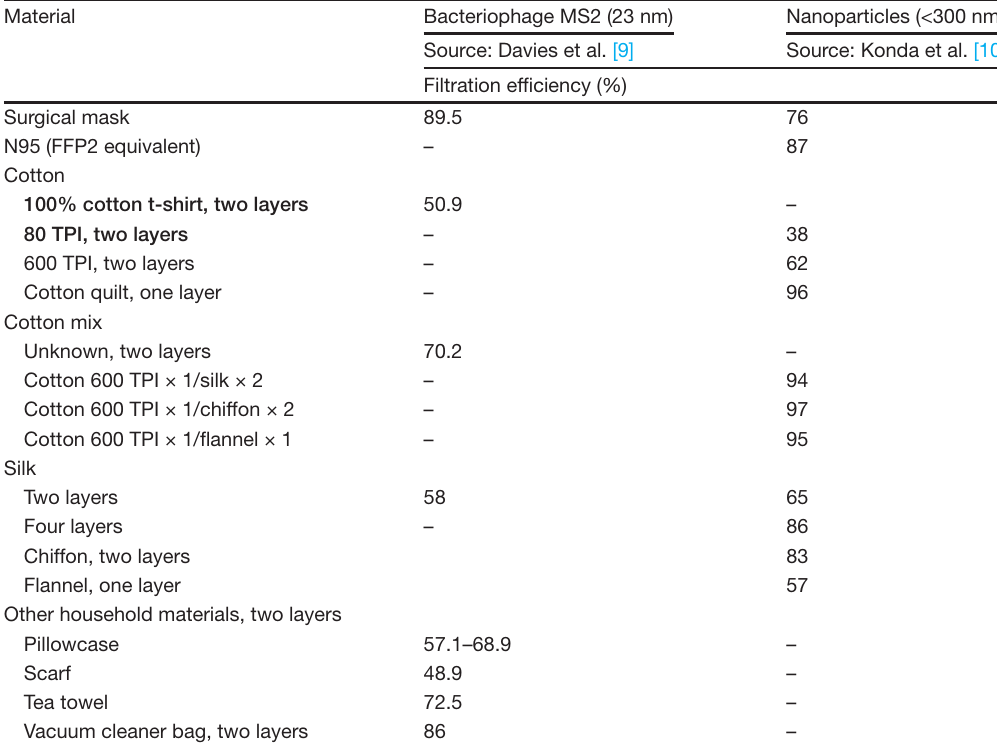
Table 2. Mask material filtration efficiencies of Bacteriophage MS2 [9] and nanoparticles [10].